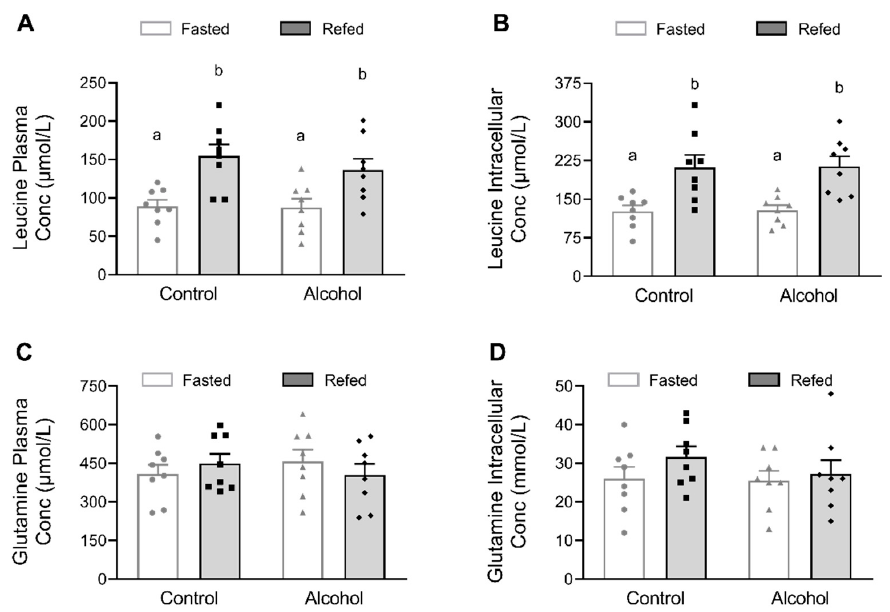
Figure 2. Plasma and intracellular muscle leucine ( A , B ) and glutamine concentrations ( C , D ) of mice in the control and alcohol-receiving groups under basal or refed conditions. Data are mean ± SEM; n = 8/ group. Values having a different superscript letter are statistically ( p < 0.05) different.